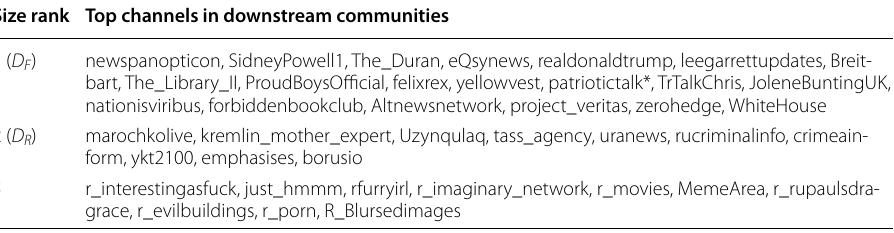
Table 4 Most important channels in the main downstream, core and upstream clusters for the network G 3 in Fig. 6 corresponding to the period March 2020 to Dec. 2020 Size rank Top channels in downstream